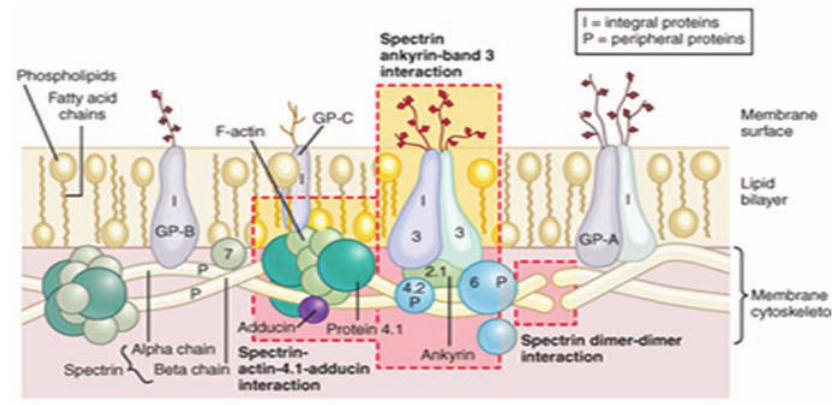
Figure 4. RBC membrane structure. 17 Legend: I = Integral Proteins; P = Peripheral Proteins; hemoglobin occupies 33% of the RBC volume and 90-95% of the dry weight; 65% of the hemoglobin synthesis occurs in the nucleated stages of RBC maturation and 35% during the reticulocyte stage; normal hemoglobin consists of 4 heme groups, which contain a protoporphyrin ring plus iron, and globin, which is a tetramer of 2 pairs of polypeptide chains.